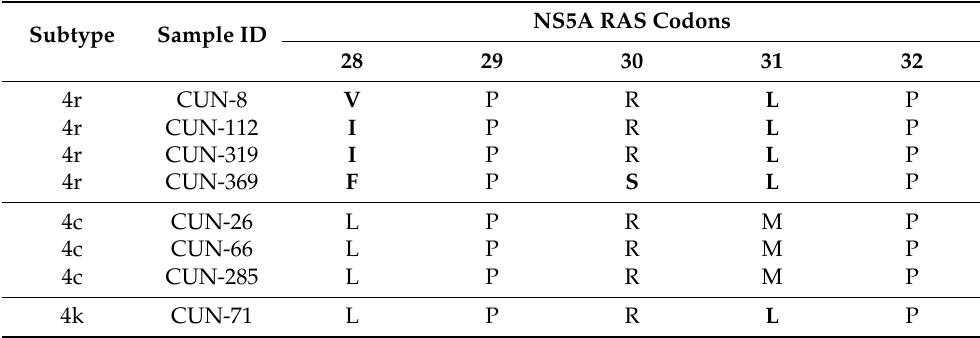
Table 4. Baseline amino acids found at the main RAS positions in NS5A region.